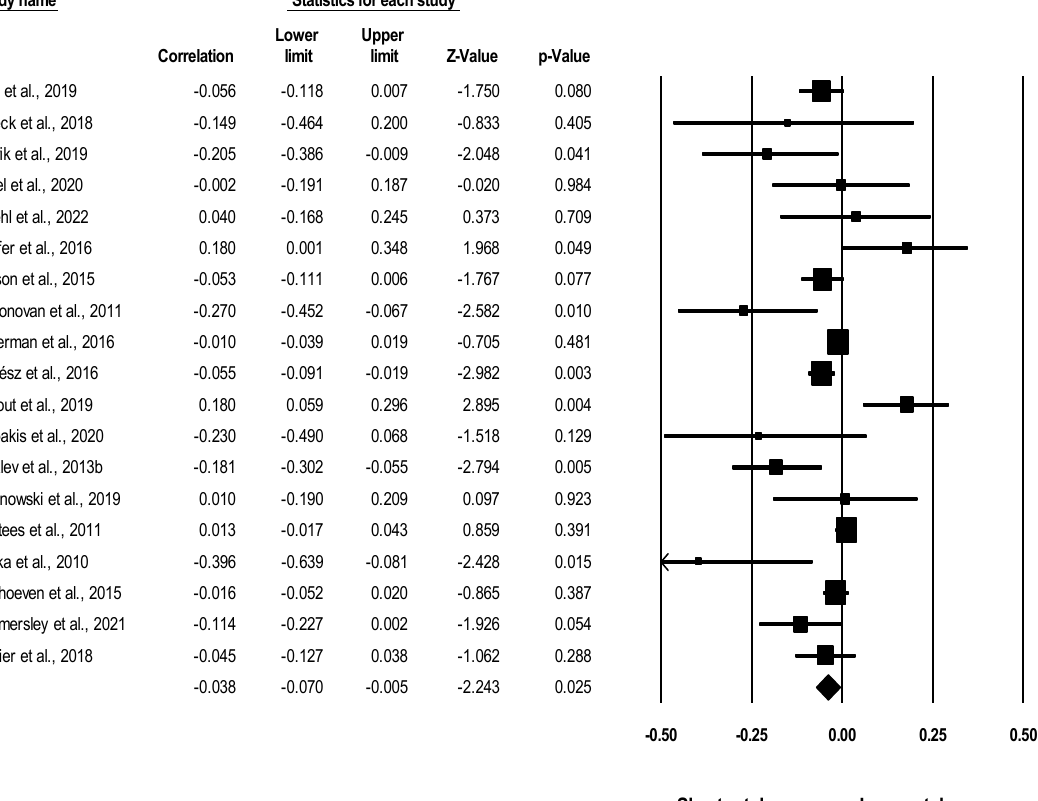
Figure 2. Forest plot of the main association between childhood exposure to family violence and telomere length in the included studies. Note. The squares in the plot show the effect size of the related study. The diamond-shaped rhombus at the bottom of all squares shows the overall effect size obtained from all studies.